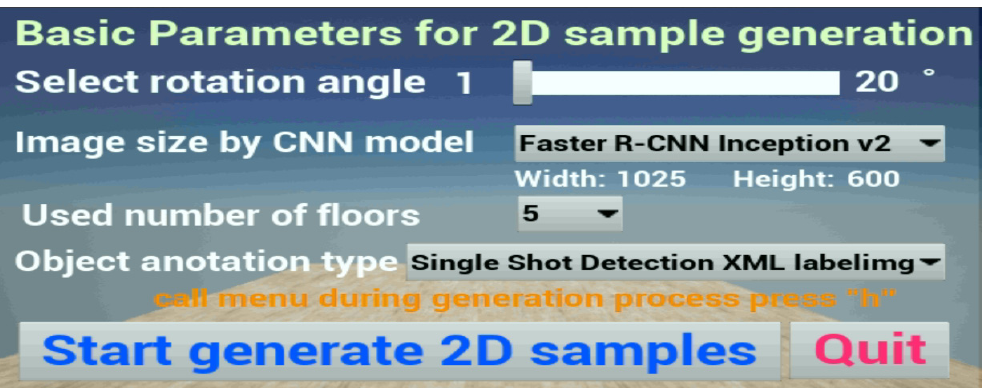
Figure 8. The Unreal Engine application setup of basic parameters for automated generation of 2D samples training and testing set.